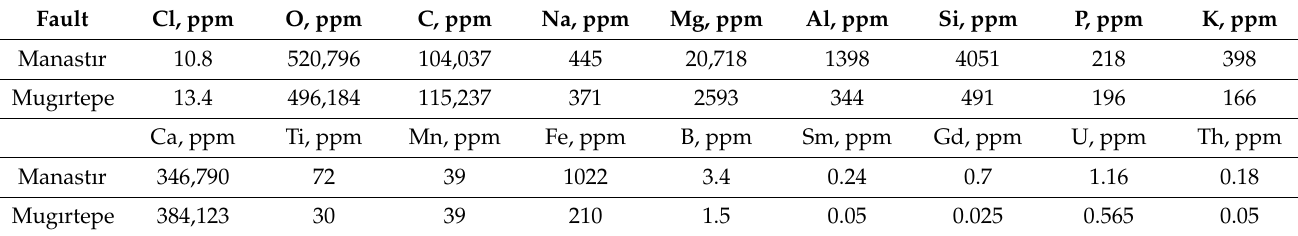
Table 4. Average chemical composition of the bedrock and colluvium of the Manastır (this study) and Mugırtepe (modified after [24]) fault scarps used in earthquake